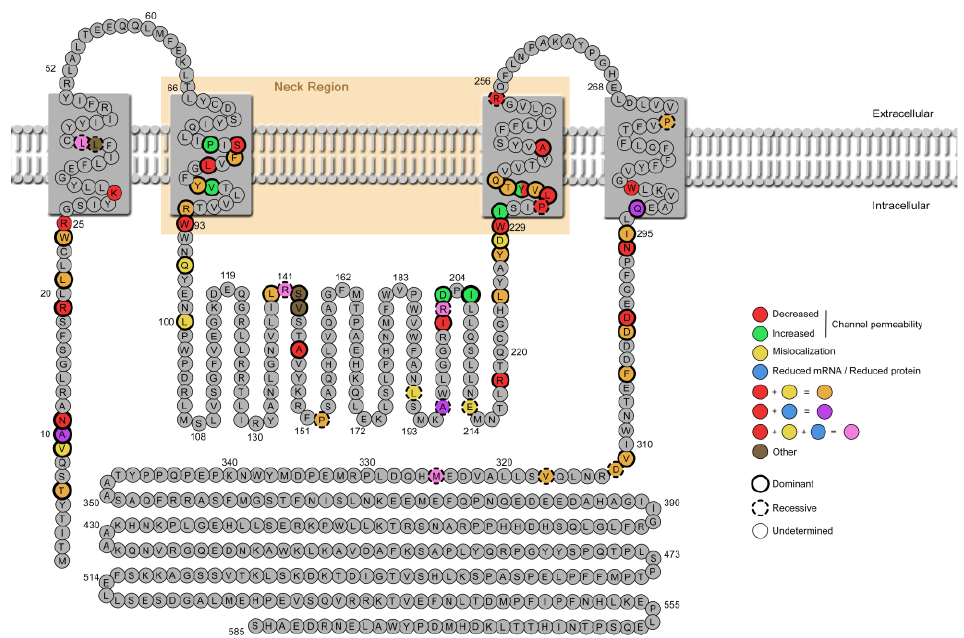
Figure 7. BEST1 -variants functionally characterized in cellular models. Protein model of bestrophin-1 (based on the structure by Boon 2009 [8]). Functionally characterized mutations from Table 1 are indicated with colors depending on the associated phenotype: decreased or increased anion channel permeability, mislocalization (apical or intracellular), or reduced mRNA or protein (includes misfolding of the protein). Variants reported with more than one effect are also represented. Dominant mutations are represented with a thicker black circle while recessive mutations are represented with a discontinuous circle. The recessive variants tested only in compound heterozygous models are not shown.